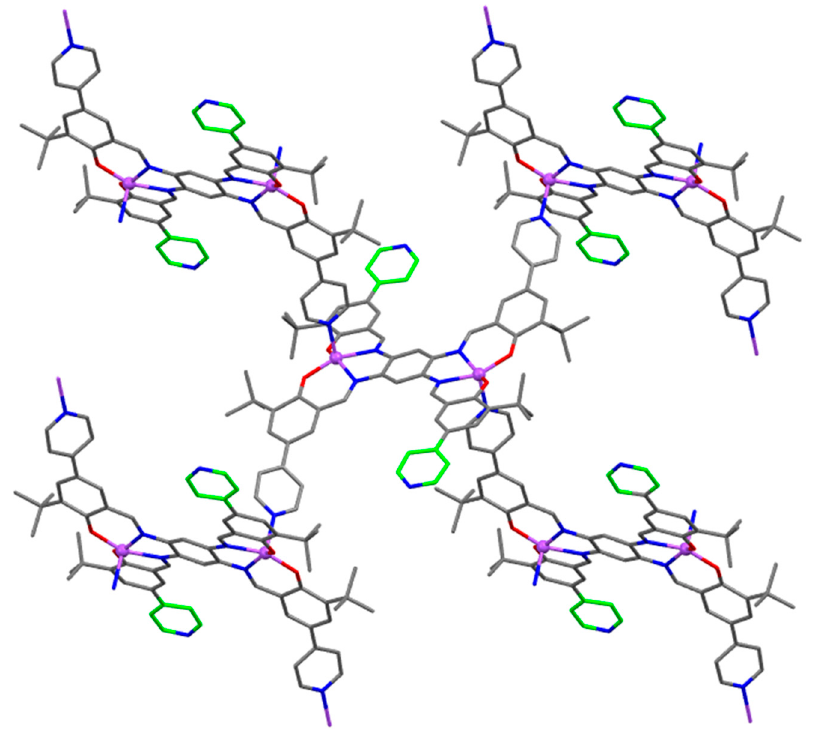
Figure 11. 2D structure of 12 showing uncoordinated pyridyl groups exposed to 1D channels. Openly accessible pyridyl groups are highlighted in green. Adapted from Ref. [53].